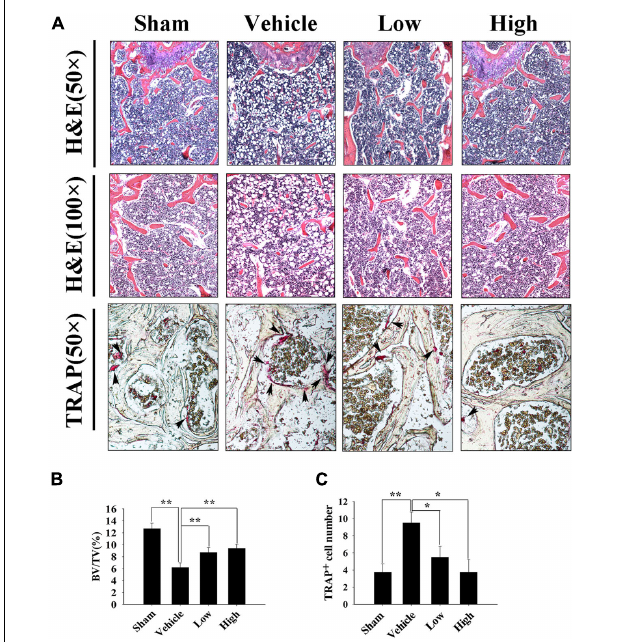
FIGURE 6 | Pra-C prevents ovariectomized (OVX) mouse bone loss as assessed with histological and histomorphometric analyses. (A) Decalcified bone tissue was paraffin-embedded and sectioned for hematoxylin and eosin, as well as tartrate-resistant acid phosphatase (TRAP) staining. Representative microscopic images are shown at the indicated magnification. Increased bone loss and TRAP-positive osteoclasts were observed in vehicle-treated OVX mice, whereas Pra-C treatment reversed the pathology, bone loss, and the number of mature osteoclasts was obviously reduced. The black arrowheads represent TRAP-positive osteoclasts observed on the surface of trabecular bone below growth plate. (B) Bone volume to tissue volume (BV/TV) and (C) the number of TRAP-positive mature osteoclasts was counted in each sample using BioQuant software. All plotted data are the means ± SE ( n = 5). ∗ P < 0.05; ∗∗ P < 0.01 versus vehicle